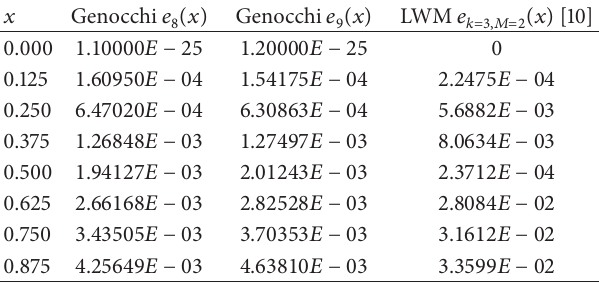
Table 7: Comparison of absolute errors for Example 5 using 𝑁 = 8 order of Genocchi polynomials with respect to Legendre wavelet method (LWM 𝑘 = 3 , 𝑀 = 2 ) of [10].